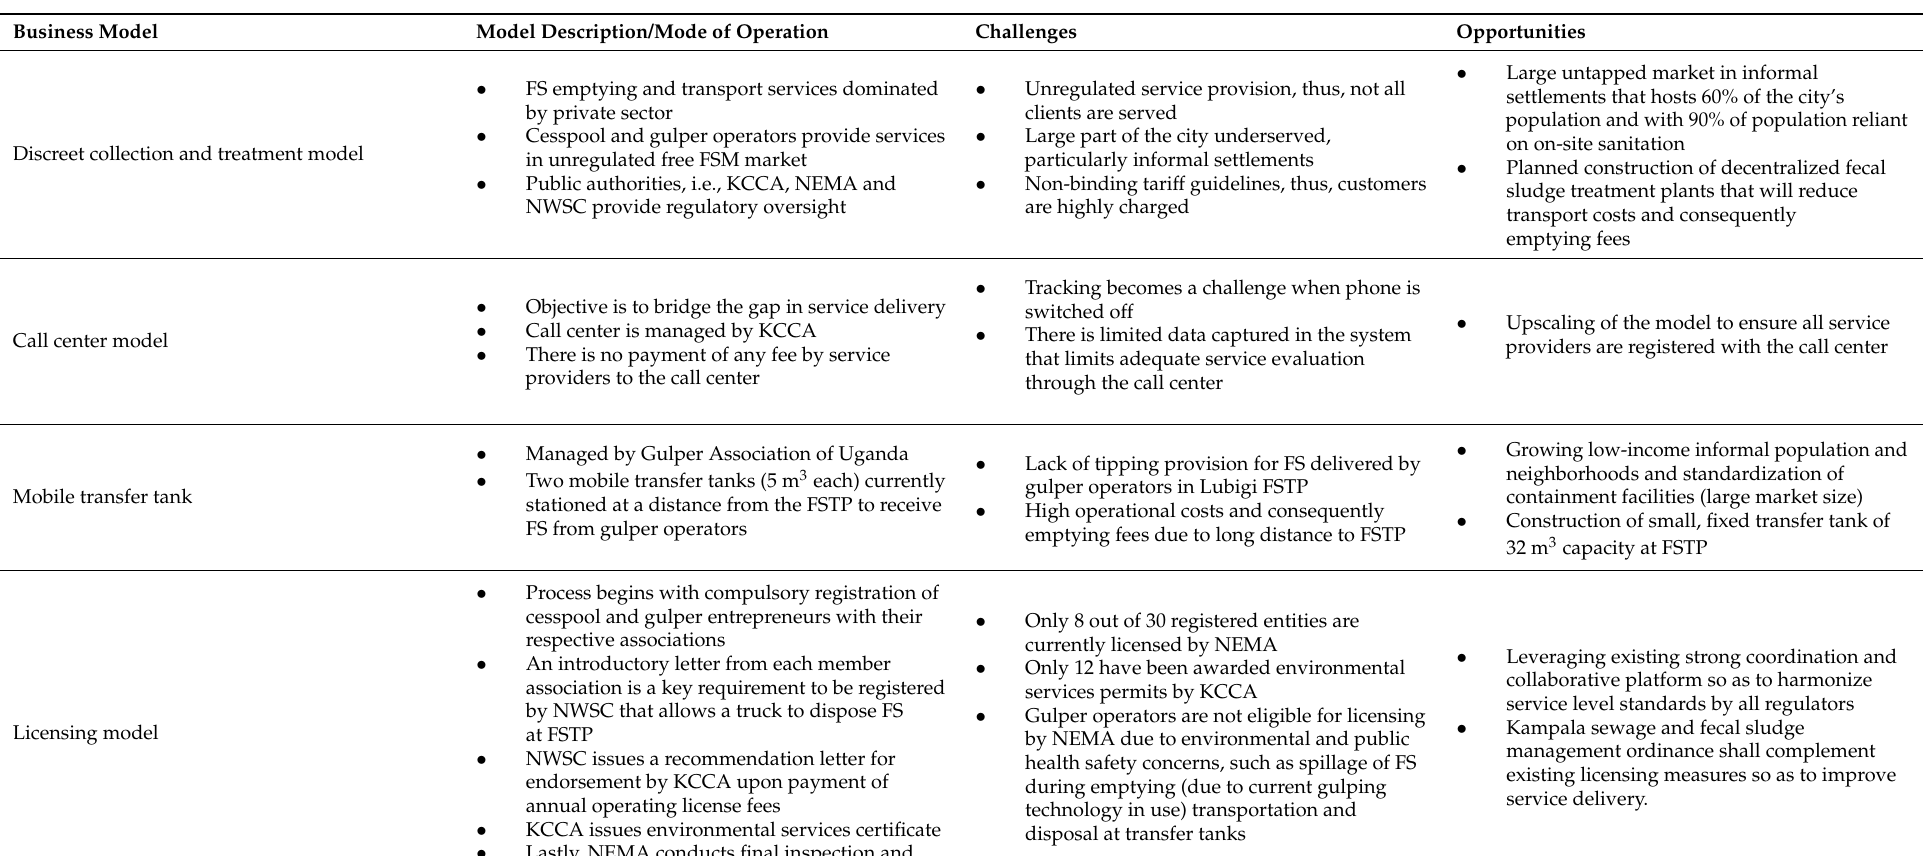
Table 2. Analysis of existing business models in